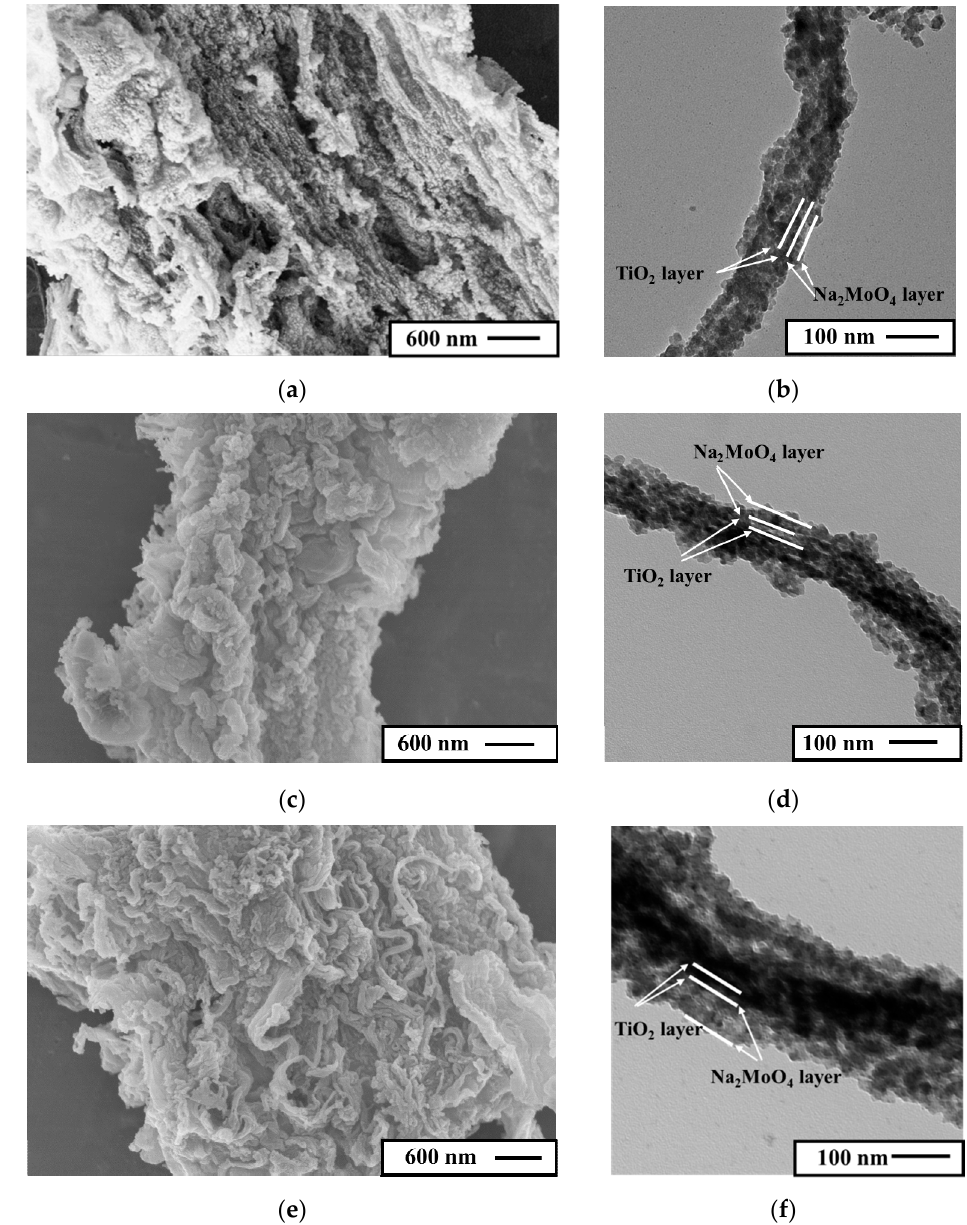
Figure 3. Electron micrographs of the nanotubular Na 2 MoO 4 /TiO 2 composites derived from natural cellulose substance. FE-SEM images of the ( a ) Na 2 MoO 4 – 15.4%-TiO 2 , ( c ) Na 2 MoO 4 – 24.1%-TiO 2 , and ( e ) Na 2 MoO 4 – 41.4%-TiO 2 composites, displaying the hierarchical network structures. TEM images of the corresponding individual composite nanotubes of the ( b ) Na 2 MoO 4 – 15.4%-TiO 2 , ( d ) Na 2 MoO 4 – 24.1%-TiO 2 , and ( f ) Na 2 MoO 4 – 41.4%-TiO 2 composites.